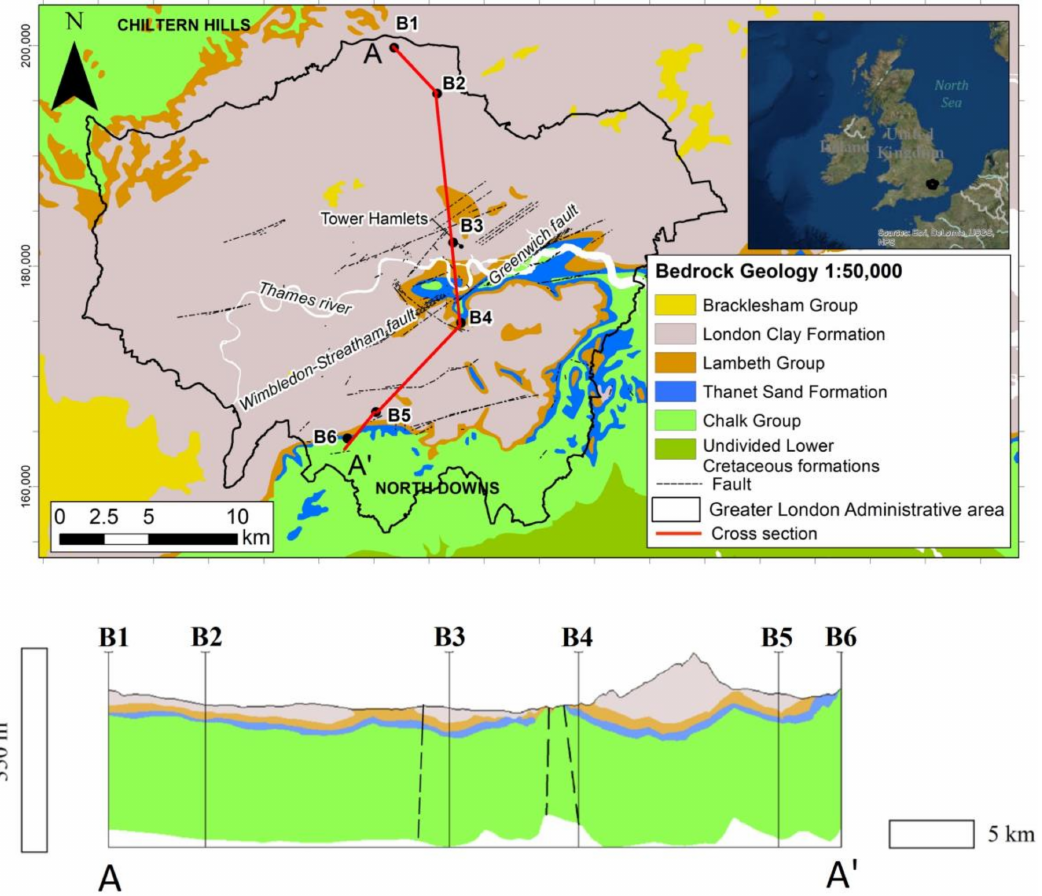
Figure 1. Location (sources: Esri, DeLorme, USGS, NPS) and geological map of London based upon the 1:50,000 bedrock geology, with the permission of the British Geological Survey. All rights reserved. British National Grid. Projection: Transverse Mercator. Datum: OSGB 1936. The geological cross section A-A’ is also reported (modified from